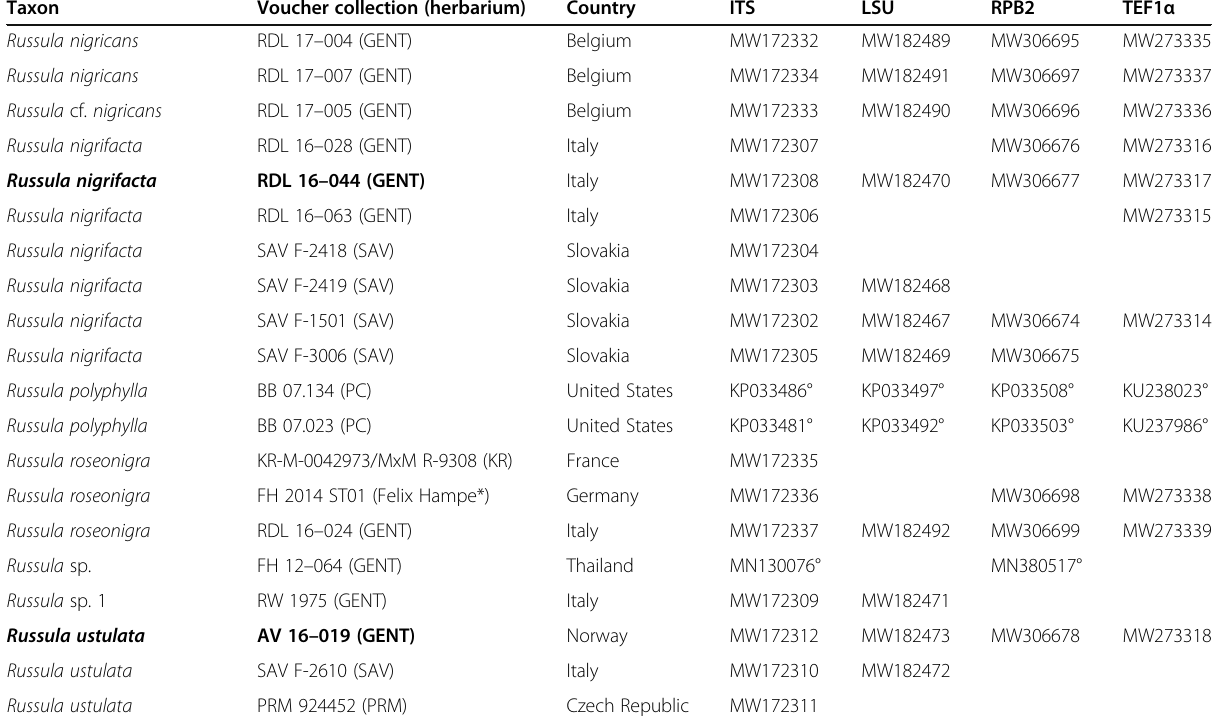
Table 1 Specimens and GenBank accession numbers of DNA sequences used in the multi-locus phylogenetic analysis